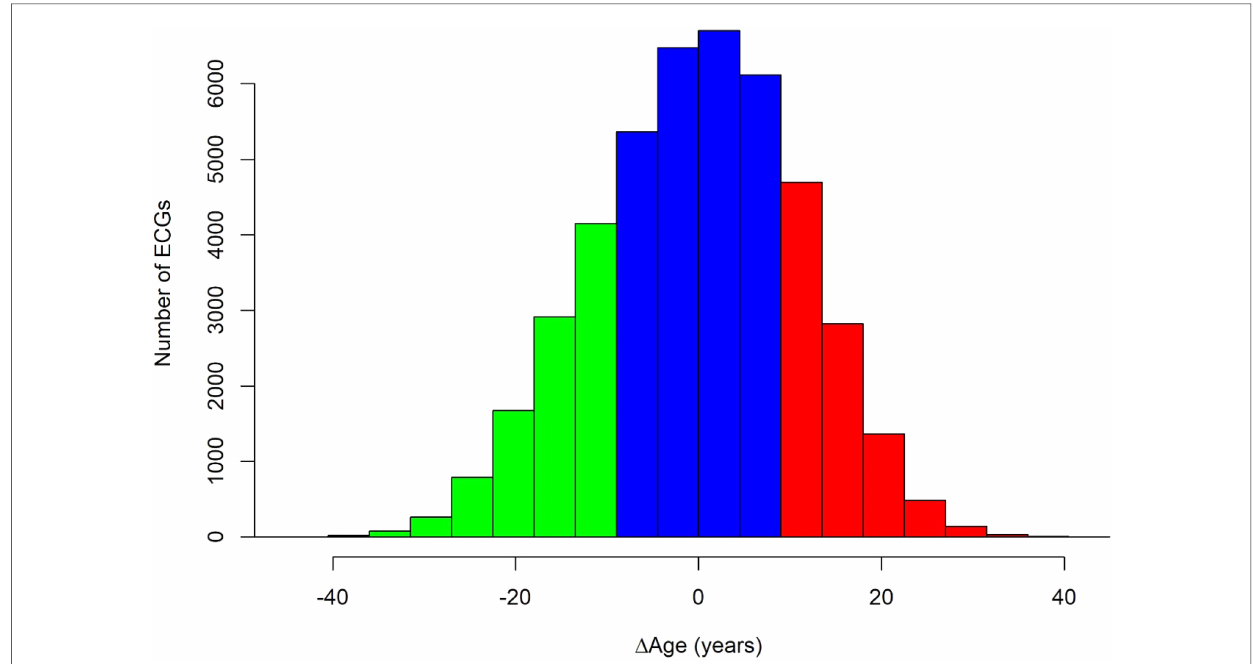
FIGURE 2 Distribution of the difference between chronological and ECG-age ( Δ age) among study participants. The fi gure is colored green for decelerated aging ( fi rst tertile), blue for normal aging (second tertile), and red for accelerated aging (third